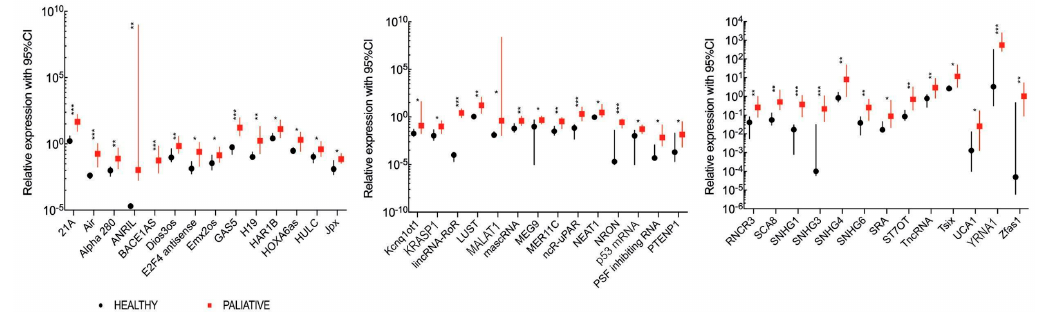
volunteers (black) and recurrent and / or metastatic HNSCC patients (red). Squares and circles represent means of expression and lines indicate 95% CI; * p < 0.05, ** p < 0.01, *** p <